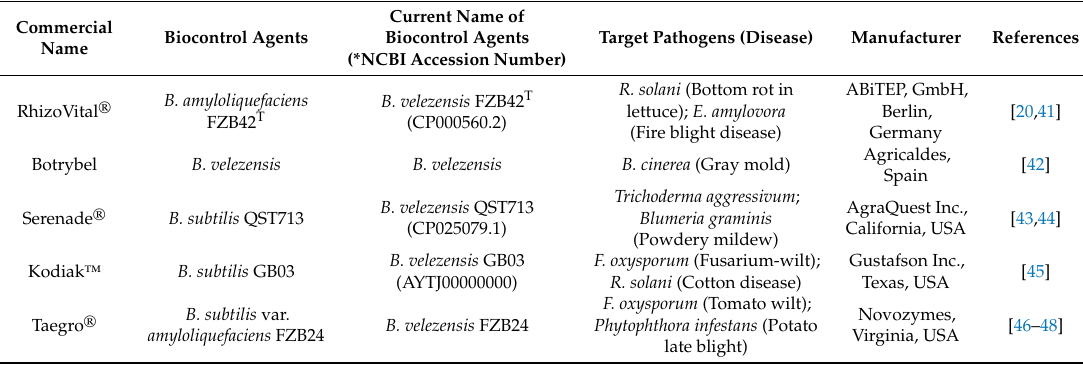
Table 2. Commercial uses of B. velezensis -based biological control in